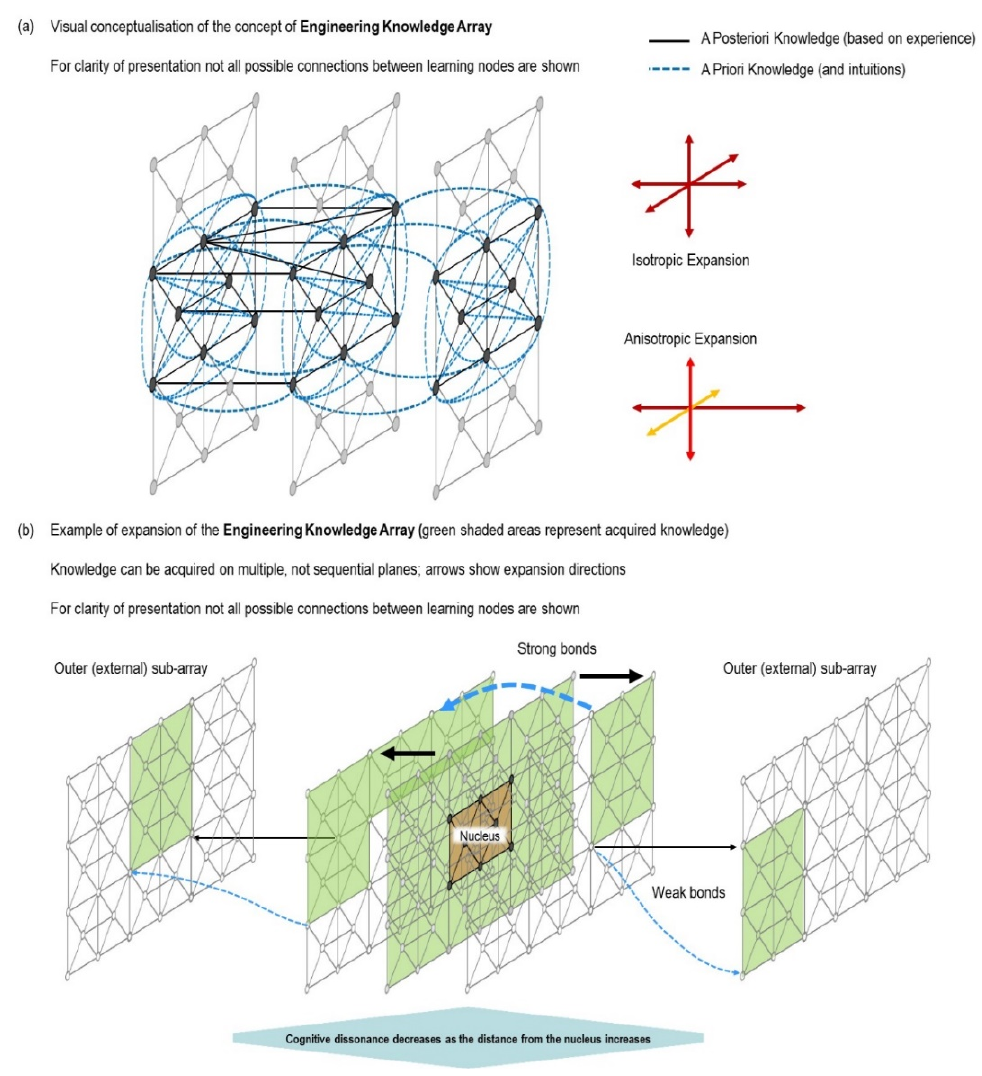
Figure 5. ( a ) Concept of 3D engineering knowledge array; and ( b ) example of knowledge expansion showing how knowledge could, in principle, be transferred across multiple planes in a non-sequential manner.